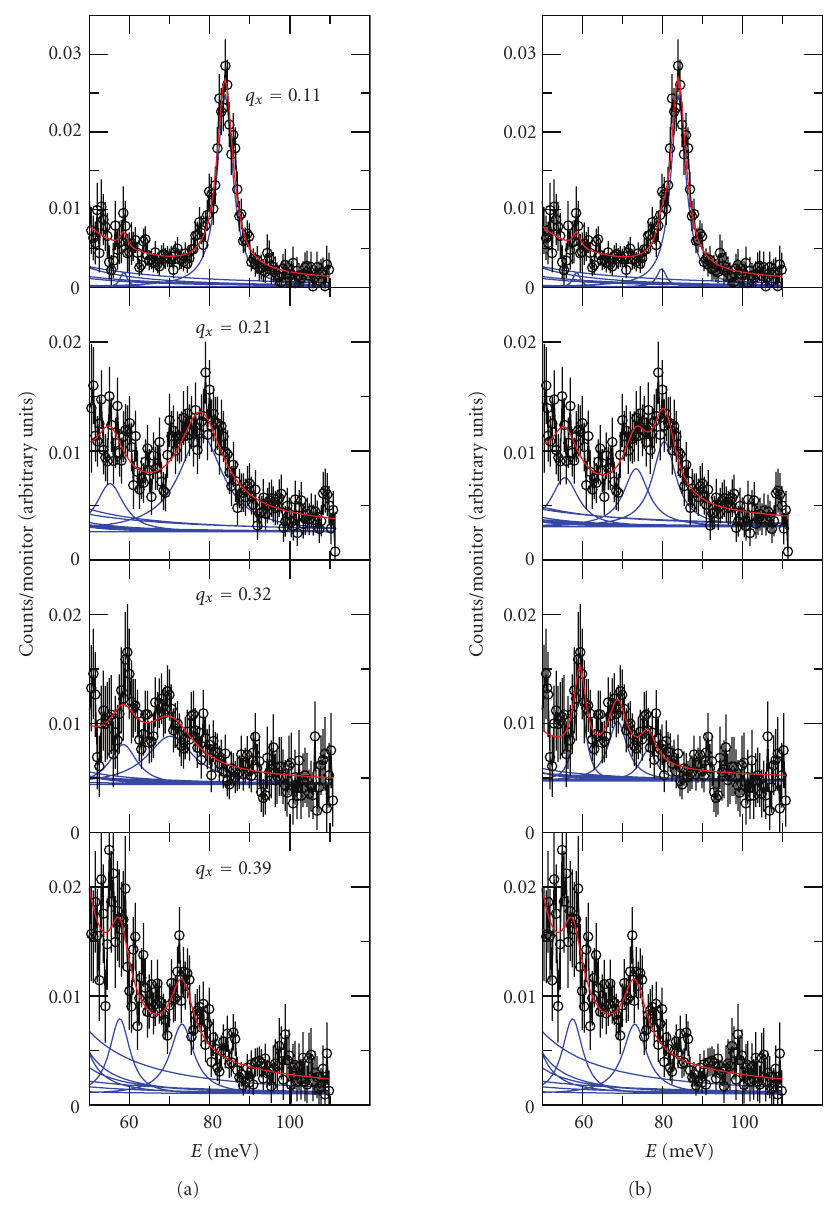
Figure 13: Inelastic X-ray scattering spectra of La 1 . 86 Ba 0 . 14 CuO 4+ δ , at Q = (3 + q x , q y , 0) ( q y < 0 . 04). In the left column a single peak is used to fit the data. In the right column the data are fitted with two Cu–O bond stretching modes (from [39]).